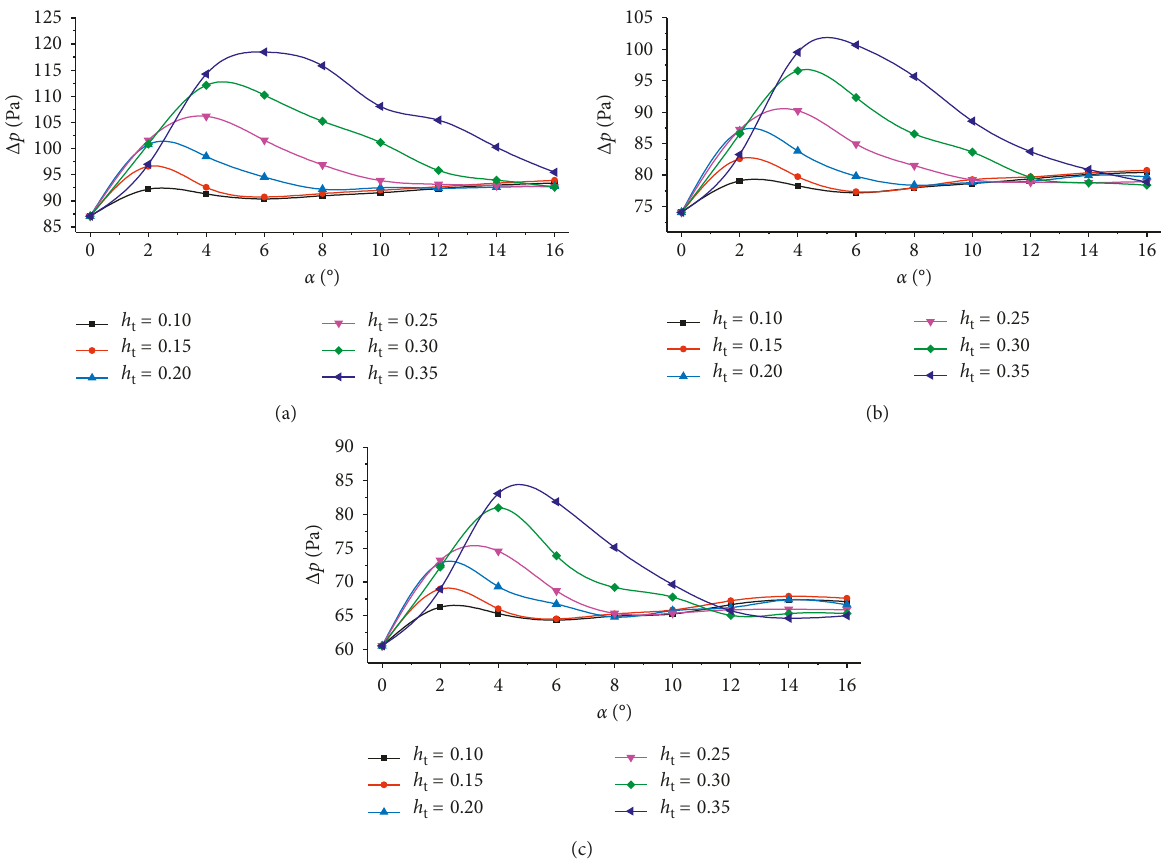
Figure 6: Curves of static pressure with α for various h